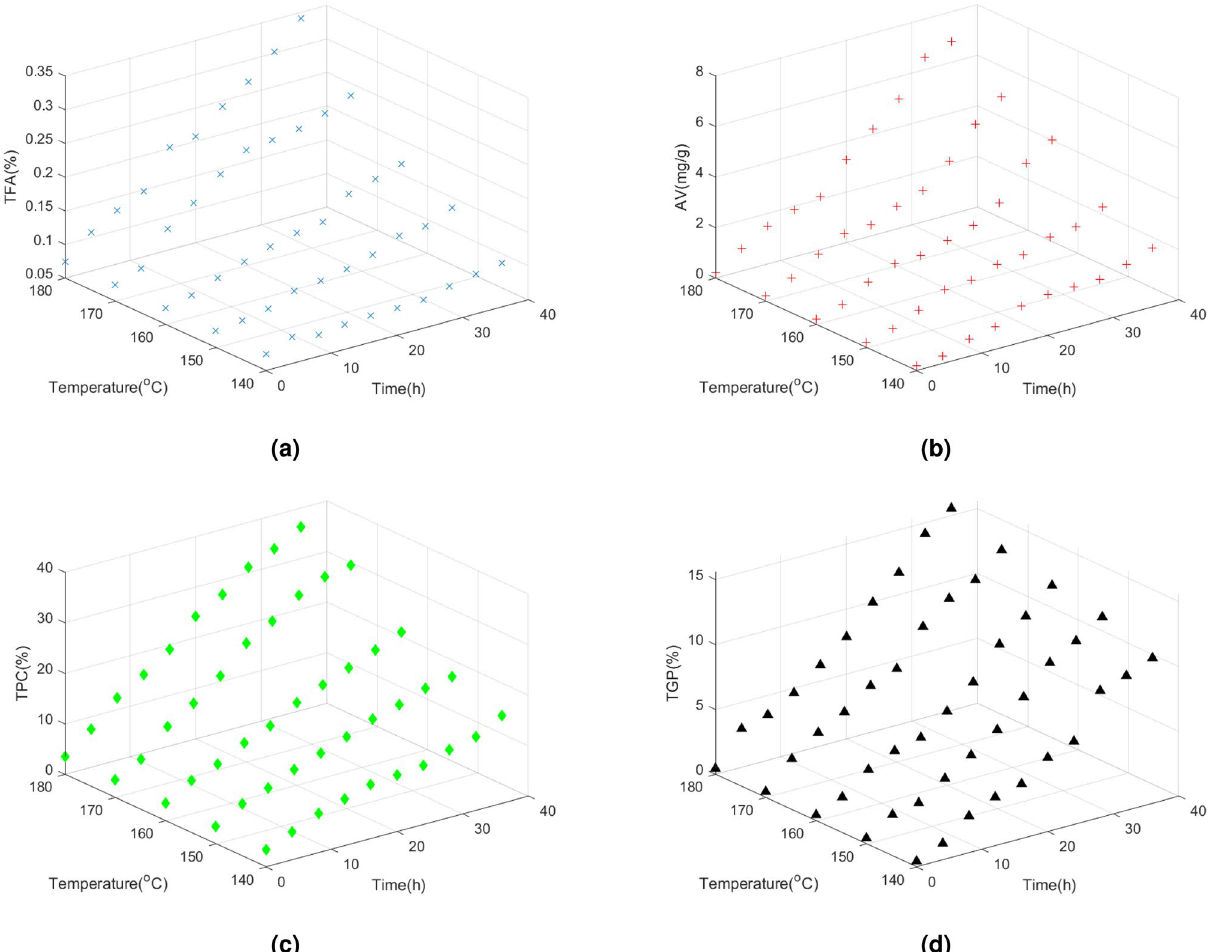
Figure 2. The above four figures show the correlation between frying time and temperature with the four